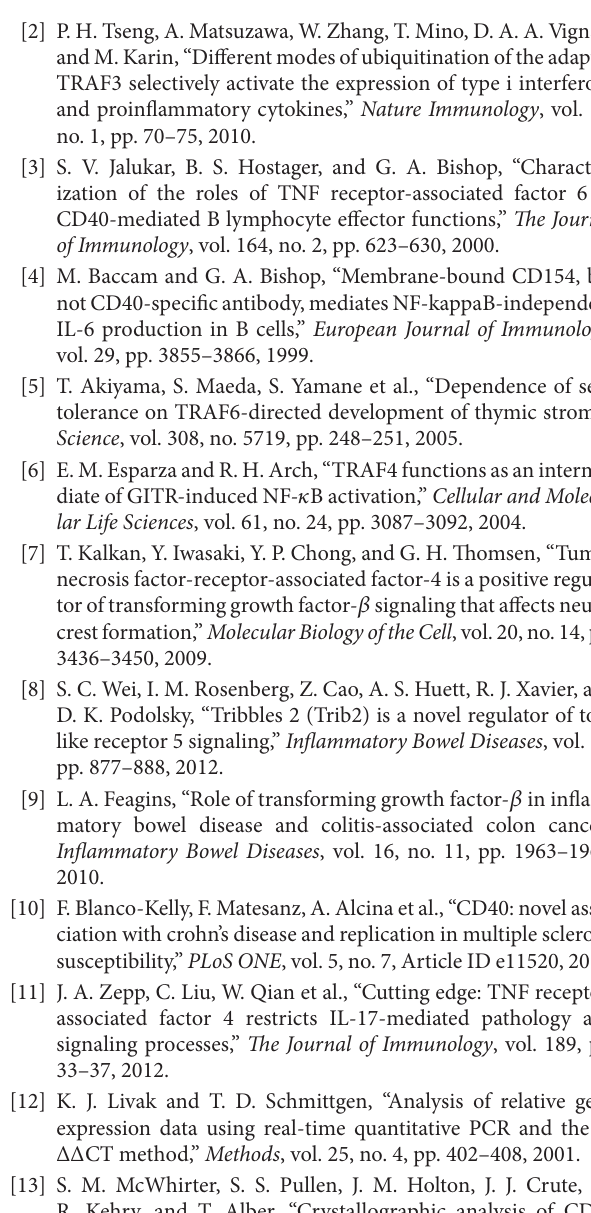
F4:WesternblotanalysesofTRAF4andTRAF6proteinexpressionsincolon.Abbreviations:CD:Crohn’sdisease;UC:ulcerativecolitis; HC: healthy controls; 1, 3: in�amed colonic mucosa; 2, 4: non-in�amed intestinal mucosa under endoscopy; 5, 6: normal colonic mucosa in healthy controls under